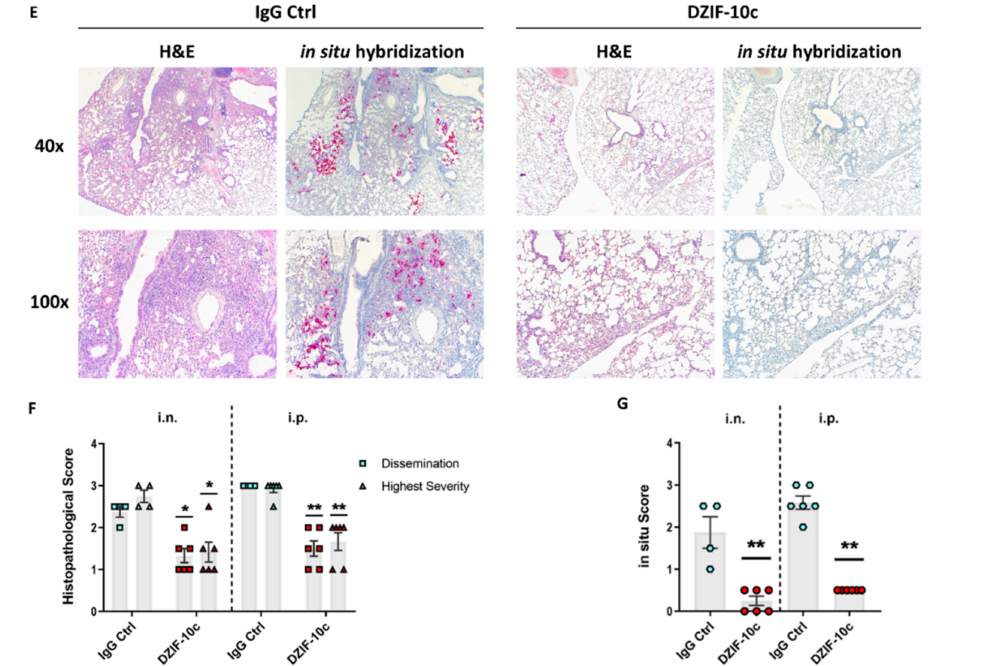
Figure 4. Viral load and histological analysis of hACE2-transduced BALB/c mice prophylactically treated with DZIF-10c. ( A ) Study plan for the prophylactic dose regimen. BALB/c mice were transduced with Ad_ACE2-mCherry three days before infection and treated i.n. or i.p. with 40 mg/KG of body weight DZIF-10c or an IgG control antibody one day prior to challenge with SARS-CoV-2. On day four post infection, the animals were euthanized, and samples were collected. Two mice from the i.n. control group had to be excluded from the analysis due to insufficient transduction efficiency. ( B ) Infectious SARS-CoV-2 titer in lung homogenates on day four post infection determined by the TCID 50 assay. ( C , D ) SARS-CoV-2 gRNA and sgRNA in lung homogenates on day four post infection determined by RT-qPCR. Error bars represent mean ± SEM. Statistical analyses were performed using Graph Pad Prism and the Mann–Whitney test. *: p ≤ 0.05; **: p ≤ 0.01. Dotted lines indicate the lower limit of detection. ( E ) Histopathological analysis of the lungs by H&E staining and in situ hybridization of viral RNA. Images were acquired at a magnification of 40 × or 100 × . ( F , G ) Quantification of histopathological scores for dissemination and highest severity of inflammation and dissemination of viral RNA. Error bars represent mean ± SEM. Statistical analyses were performed using Graph Pad Prism and the Mann–Whitney test. *: p ≤ 0.05; **: p ≤